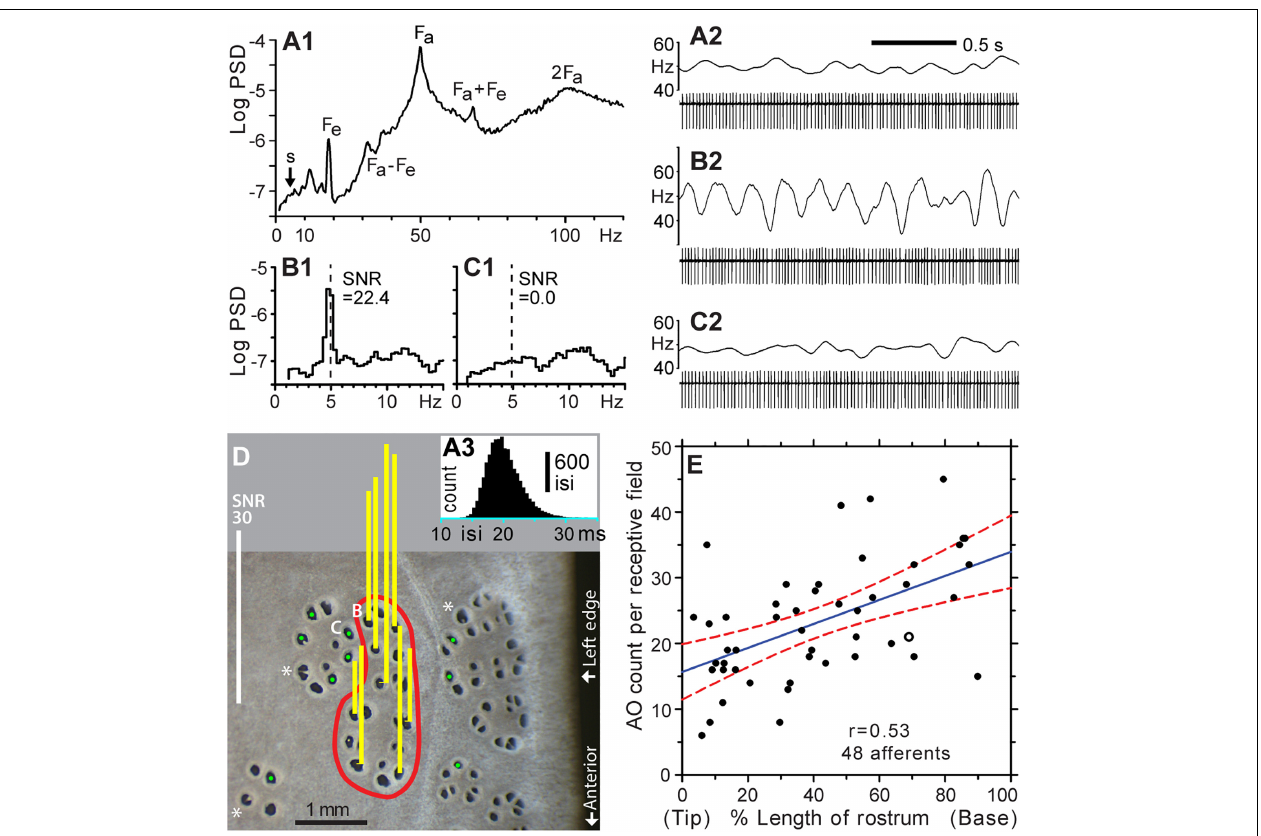
FIGURE 3 | Functional mapping of receptive fields by microstimulation of individual ER pores. (A1–A3) Background firing of an ALLn sensory neuron without external stimulation, at mean 49.7 Hz. (A1) Power spectral density (PSD, logarithmic scale, ∼ 0.31-Hz binwidth), was calculated from 14,924 spikes, 5-min data. (A2) Raw recording, 2 s. (A3) Histogram of all interspike intervals (isi) in 5-min data; 0.5-ms bins. The single-unit afferent was recorded extracellularly via a microelectrode in an ALLn ganglion, and digitized at 20 kHz. The PSD was calculated from a derived 20-kHz sampled voltage channel of zero values with a single 1-V sample at each detected spike time. Labels mark the fundamental frequency of an afferent oscillator (Fa) and epithelial oscillations (Fe), and combinations or multiples of these (Fa + Fe, Fa – Fe, 2Fa). (A2,B2,C2) Spike amplitudes in filtered (100–1000 Hz) recordings were approximately 510, 460, or 640 µ V, respectively. Firing rates (upper trace in each panel) were smoothed in Spike v7 software by summing a unit-area Gaussian waveform, of 50 ms-SD and 200-ms total width, at each spike time. (B1,2) Modulation of afferent firing from 10 cycles of 5 Hz, ± 2.5 nA peak–peak, sine wave stimulation of the pore labeled (B) in panel (D) . (B1) PSD from 2,870 spikes, 1-min recording. The signal:noise ratio (SNR = 22.4) at 5 Hz was calculated as the ratio of summed net (total minus noise) response power in three signal bins centered on 5 Hz, to the summed extrapolated power of baseline noise in these three bins, averaged from below and above the response band. (B2) Raw recording, 2 s, 10 stimulus cycles. (C1,2) Nil response (SNR = 0.0) of a pore in an adjacent cluster, labeled (C) in (D) , for 5 Hz ± 2.5 nA sine wave stimulation (dashed line). (C1) PSD from 2,828 spikes, 1-min recording. (C2) Raw recording, 2 s, 10 stimulus cycles. (D) This photo of skin pores on the rostrum surface shows the receptive field (red boundary) of the afferent unit for panels (A–C) . Sensitivity for 5 Hz ± 2.5 nA sine wave stimulation was measured at every skin opening within the red boundary; yellow bars show response SNR at selected pores. Pores in the receptive field were defined by SNR > 9, measured as in (B) . Pores outside the receptive field yielded nil response (SNR ∼ 0, marked by green dots, • ). , Large pores with partial septa. (E) Counts of ampullary organs (AO) in the receptive fields of 48 different afferents were mapped on the left-side dorsal surface of the rostrum of six paddlefish of ∼ 1-year age. The blue solid line shows the least squares regression (correlation coefficient r = 0.53), and red dashed curves shows its 95% confidence intervals, from SigmaPlot software. The x axis shows locations of the mapped receptive fields along the rostrum length, expressed as percentage of distance from the rostrum tip (0%) to the dorsal nares (100%). The open circle corresponds to the receptive field in (D)